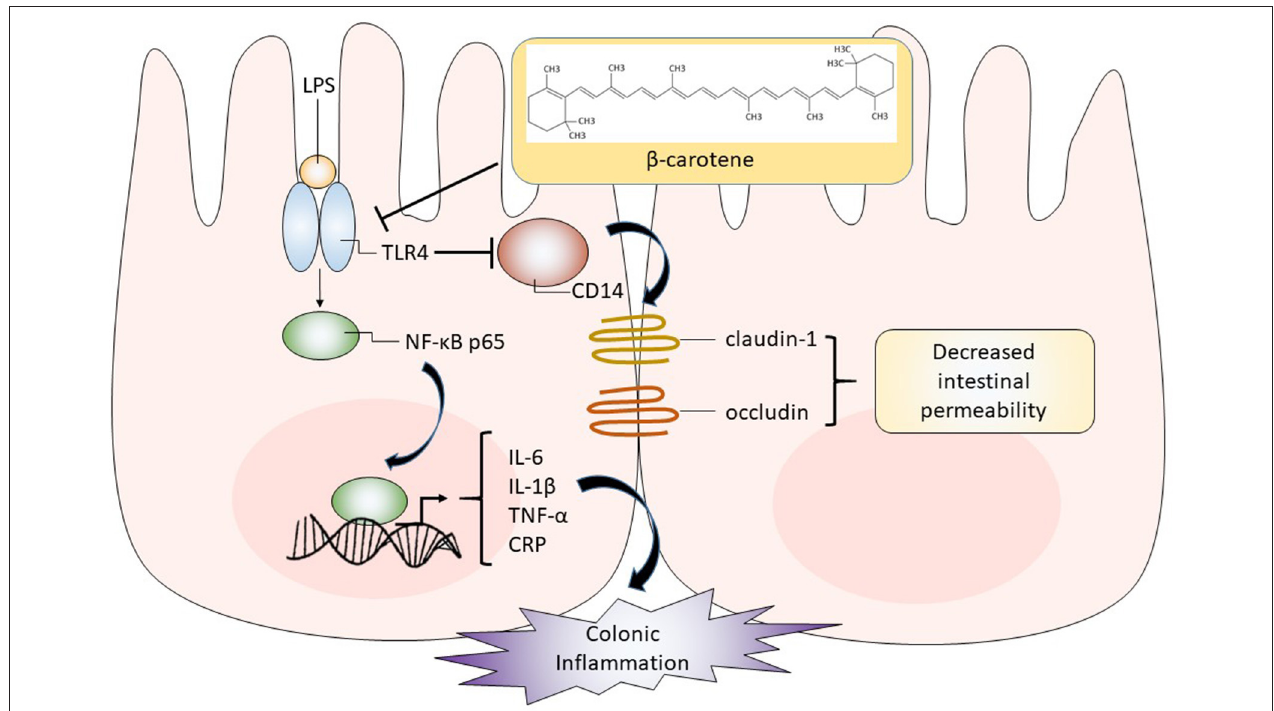
FIGURE 7 | Graphical representation of proposed pathway in which β -carotene impacts colonic epithelial cells. β -Carotene effectively inhibits the LPS-induced inflammatory response within HT-29 colonic epithelial cells by downregulating TLR4, which may block the activation and nuclear translocation of the NF- κ B p65 subunit and related downstream signaling. Thus, the release of pro-inflammatory cytokines (IL-6, IL-1 β , TNF- α ) is compromised. The β -carotene induced downregulation of TLR4 may also alleviate the inhibition of its co-receptor CD14. Enhanced CD14 levels by β -carotene may upregulate tight junction proteins (claudin-1 and occludin), leading to decreased intestinal permeability and enhanced barrier